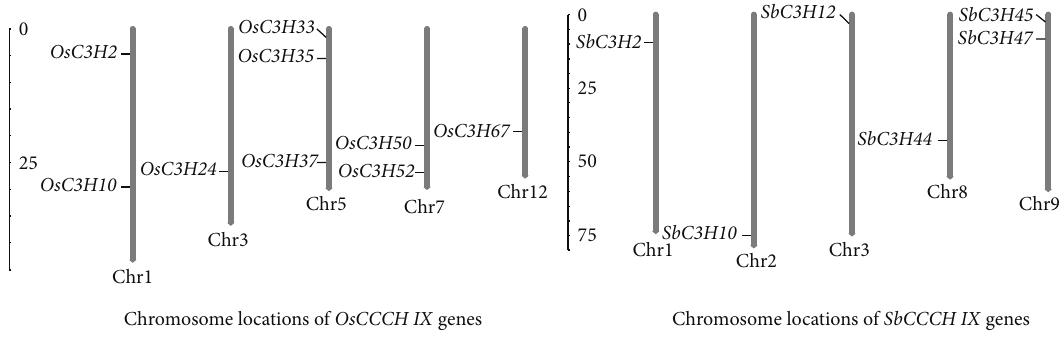
based on protein sequence alignment. The phylogenetic tree is divided into four clades (Figure 2(a)). Although different clades have different numbers of members, clades 1–3 consist of proteins from all three grass species, whereas S. bicolor pro- teins are absented from clade 4. These differences may have been derived from partial gene loss that may have